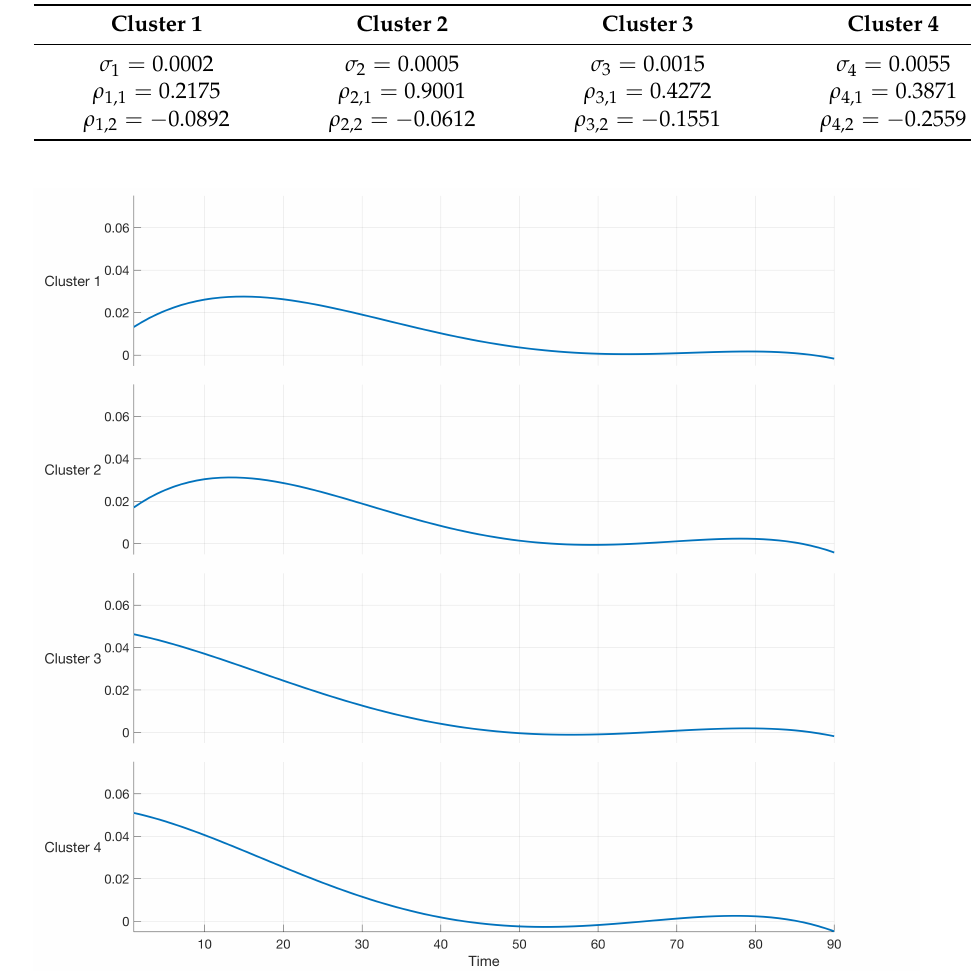
Table 4. Sigma values and correlation factors of lag 1 and lag 2, for polynomial regression mixtures.